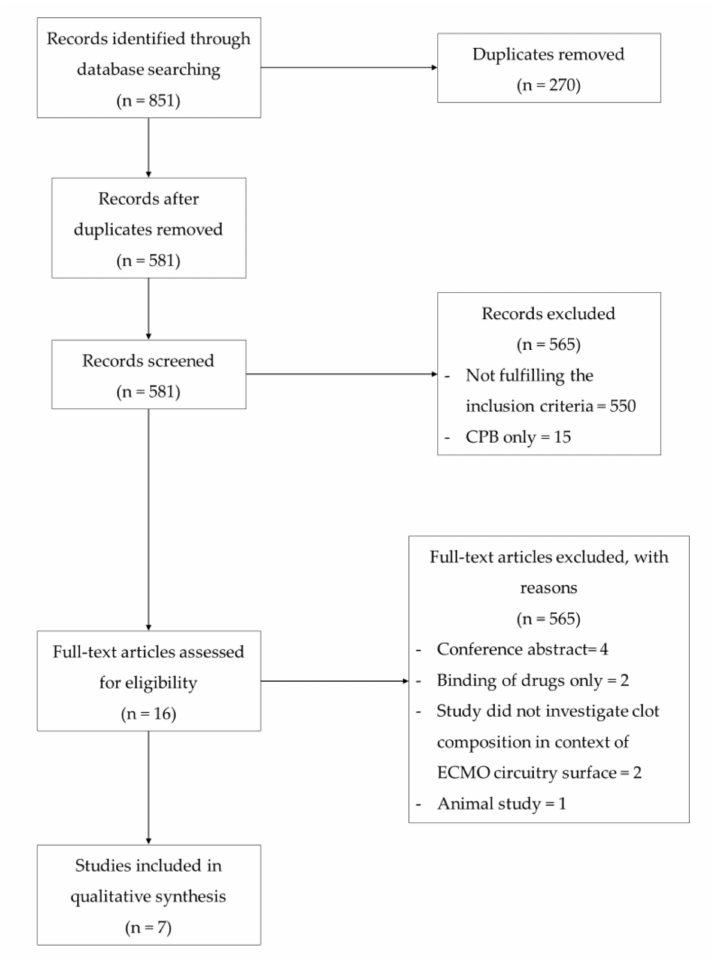
Figure 1. Summary of the study selection process for the systematic